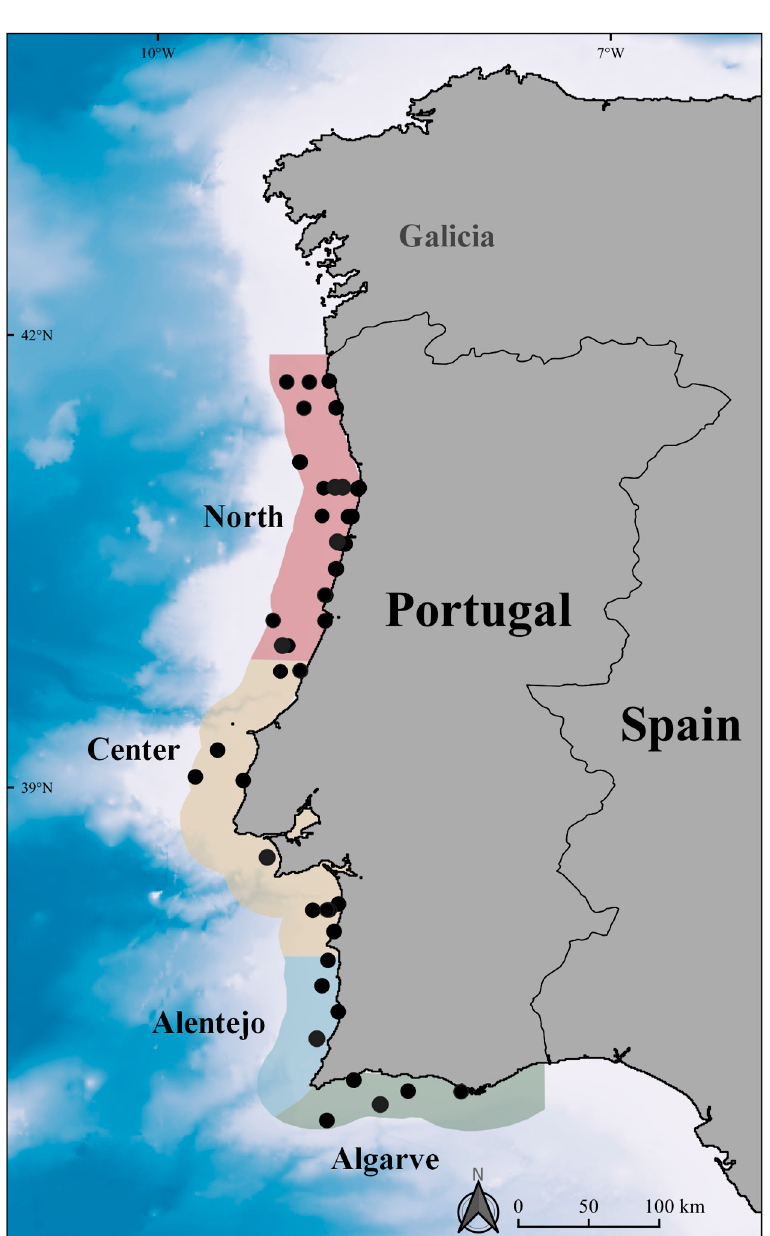
Figure 2. Harbour porpoise sightings during aerial surveys between 2011 and 2015 in the survey area divided into four sectors: North, Centre, Alentejo, and Algarve.